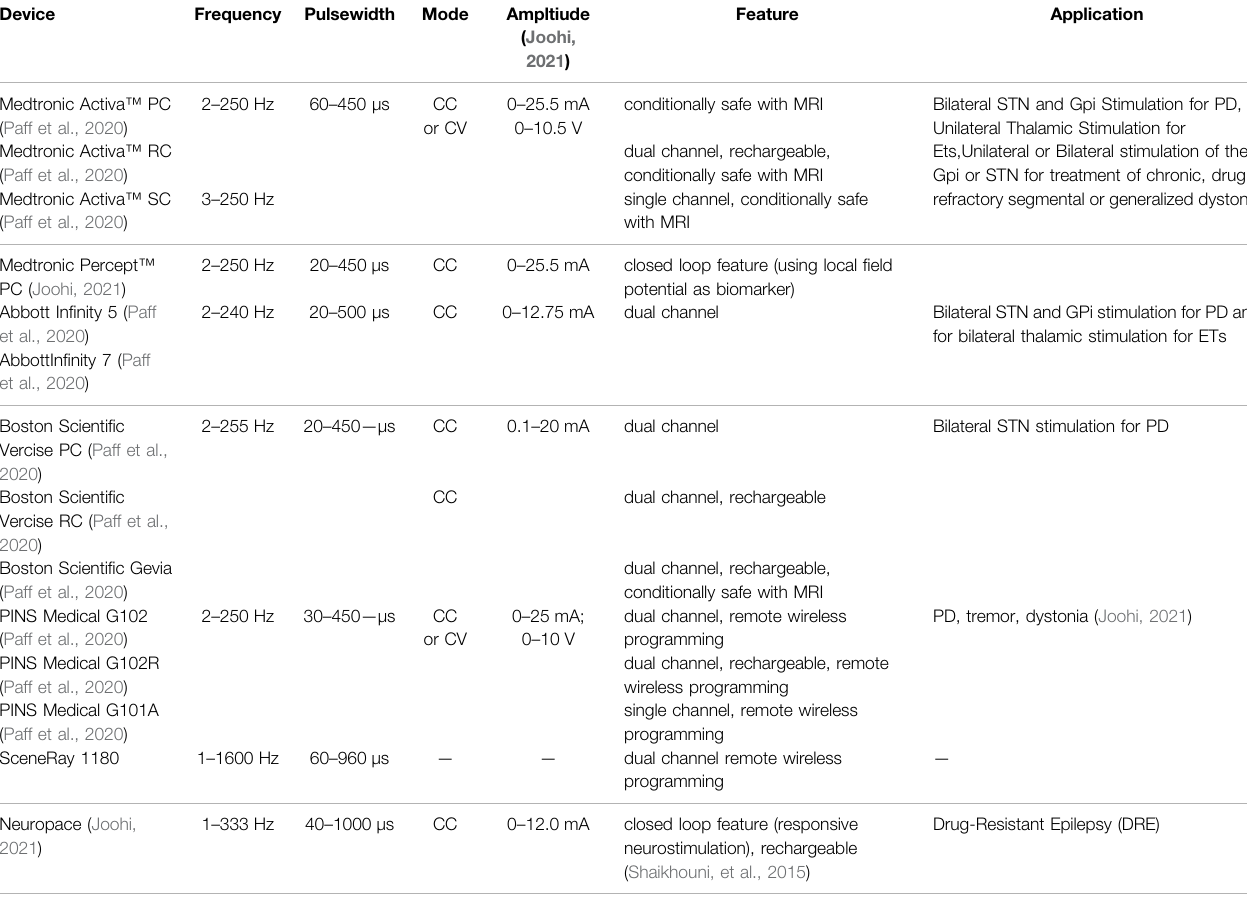
TABLE 3 | Commercially available IPG devices.